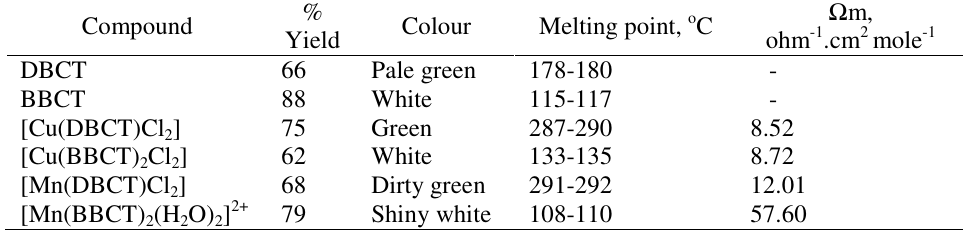
Table 1. Some physical data of the ligands and complexes